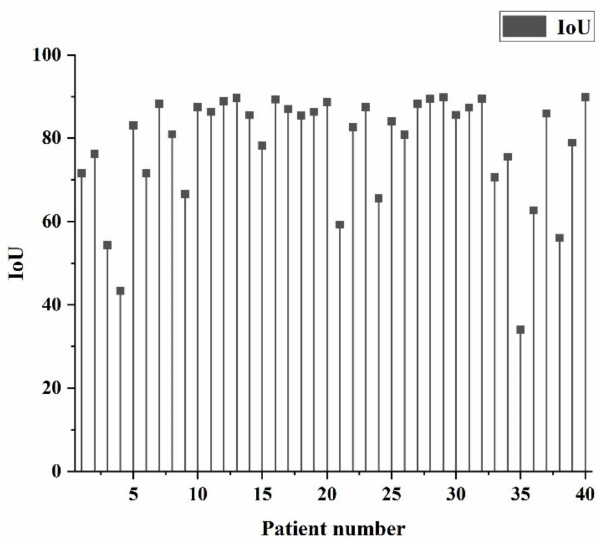
Figure 8. Distribution of IoU by patients after training with additional 30 hospital imaging data sets.